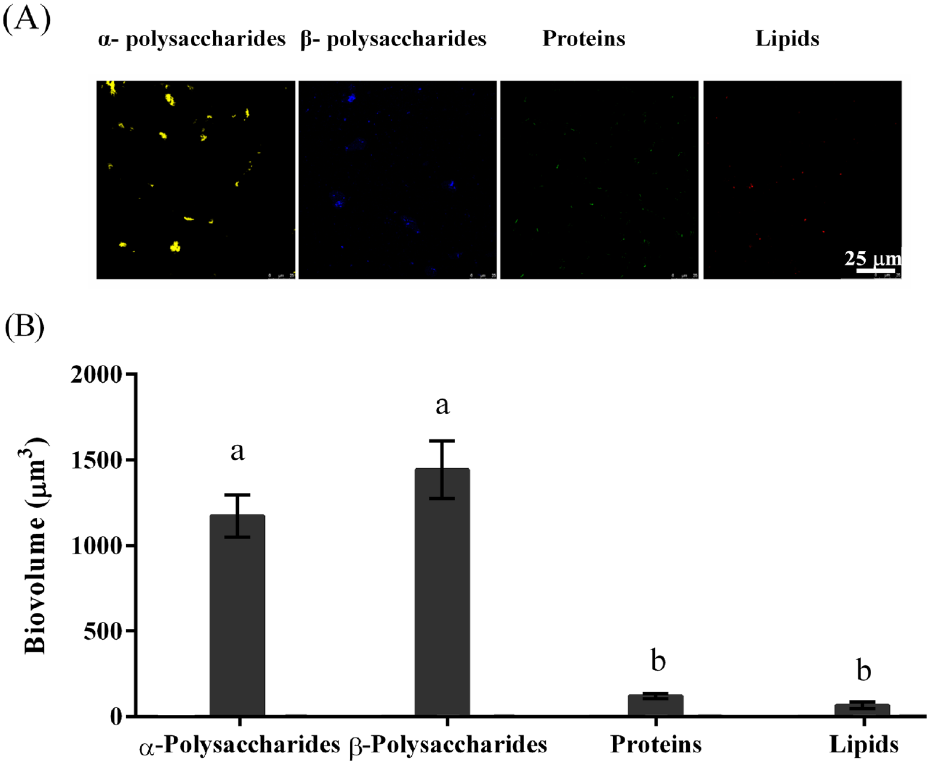
Figure 7. CLSM images ( A ) and biovolumes ( B ) of biofilm extracellular polymeric substances of Virgibacillus sp. 1 BFs. Alpha-polysaccharides were combined with Concanavalin A, tetramethylrhodamine conjugate; β-polysaccharides were combined with calcofluor white M2R; proteins were combined with fluorescein isothiocyanate isomer I; lipids were combined with DiIC18(5) oil, 1,1 ′ -dioctadecyl-3,3,3 ′ ,3 ′ - tetramethylindodicarbocyanine